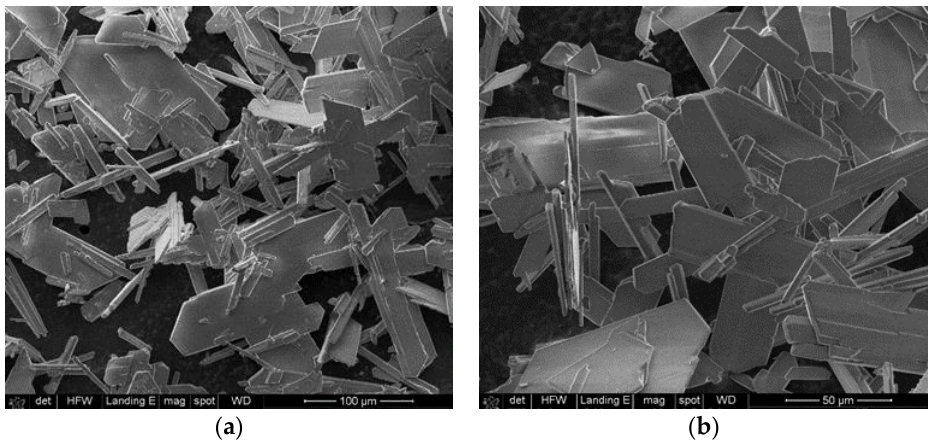
Figure 2. Micrographs of the seed crystals. Scale bar = 100 µm in 4.2 ( a ) and 50 µm in 4.2 ( b ).